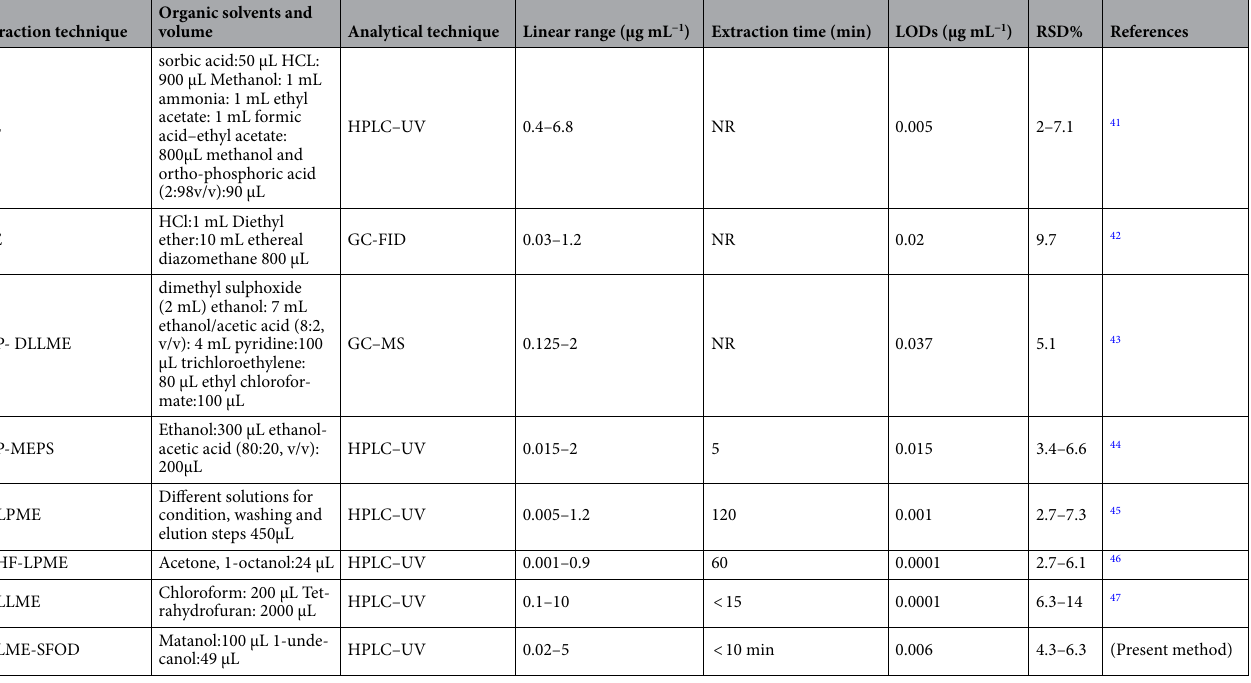
Table 5. Comparison of the SFO-DLLME method with other preconcentration techniques for monitoring of urinary t,t-MA. SPE solid-phase extraction, LLE Liquid–liquid extraction, DLLME dispersive liquid–liquid